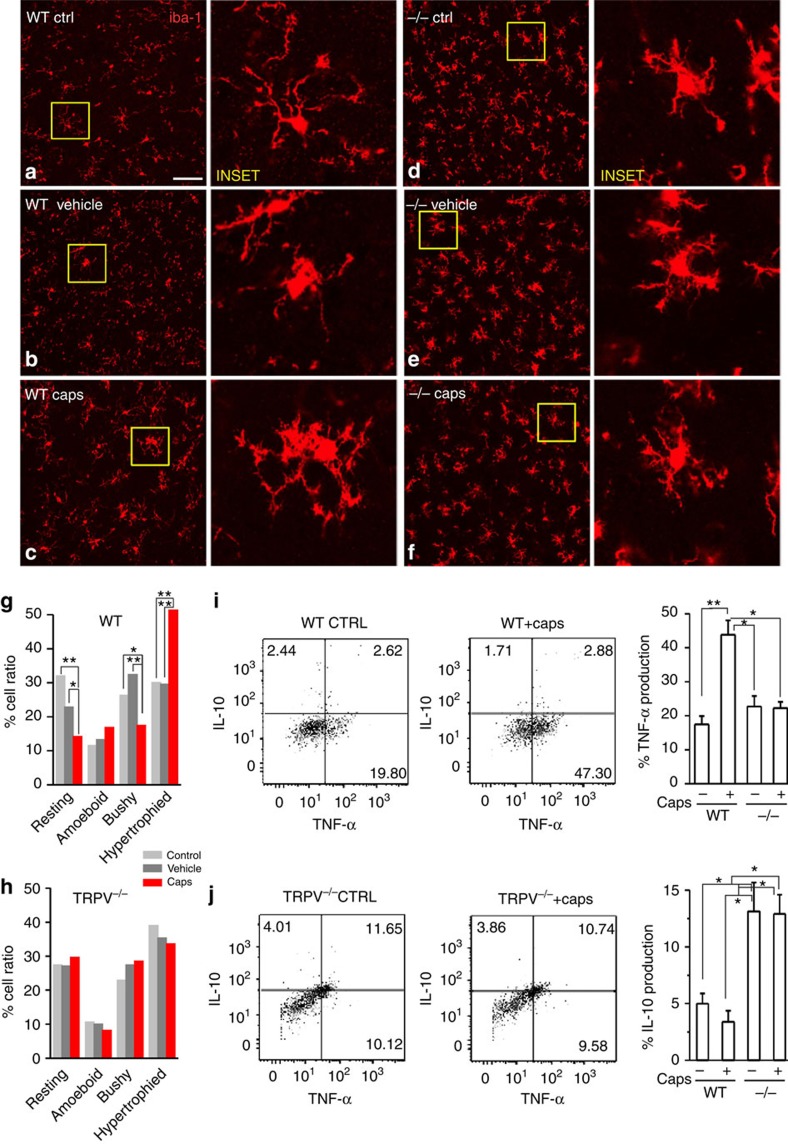
The presence or absence of TRPV1 influences microglia phenotype.(a–f) Sections of cortical tissue from WT and TRPV1−/− mice, fixed after exposure to ACSF (a,d), ACSF plus vehicle (DMSO; b,e) and ACSF plus 1μM capsaicin (c,f) and immune-processed for iba-1 to stain microglia cells (in red). INSETs are zoom images taken from an area delimited by the yellow square for each condition. (g), Bar graph of percentage of cortical microglia cell phenotype (resting, ameboid, bushy and hypertrophied), in control (grey bars), vehicle- (dark grey bars) and capsaicin- treated (red bars) cortical sections from WT mice. Capsaicin treatment causes a significant shift from ramified and bushy to hypertrophied morphology. (h), Same as in ‘g' but in cortical sections from TRPV1−/− mice. In these tissues capsaicin fails to induce morphological changes of microglia cells. Note that microglia cells in −/− tissues are already hypertrophied in control conditions (d–f,h). *P<0.05, **P<0.01 Fisher exact test. Acutely isolated CD11b+ microglial cells from WT (i) and TRPV1−/− mice (j) were cultured in the absence (−) or presence (+) of capsaicin (1 μM) for 10 min, washed and then incubated with Brefeldin A for 6 h to allow cytokine accumulation in vesicles. Intracellular production of TNF-α and IL-10 was analysed by means of flow cytometry. Data represent percentage of cytokine production±s.e.m. of 3 independent pools of at least 3 mice. *P<0.05, **P<0.01 (Bonferroni's multiple comparison test following parametric one-way Anova). Note that ‘Percentage of TNFalpha/IL-10 production' means the ‘Percentage of TNFalpha producing cells'.